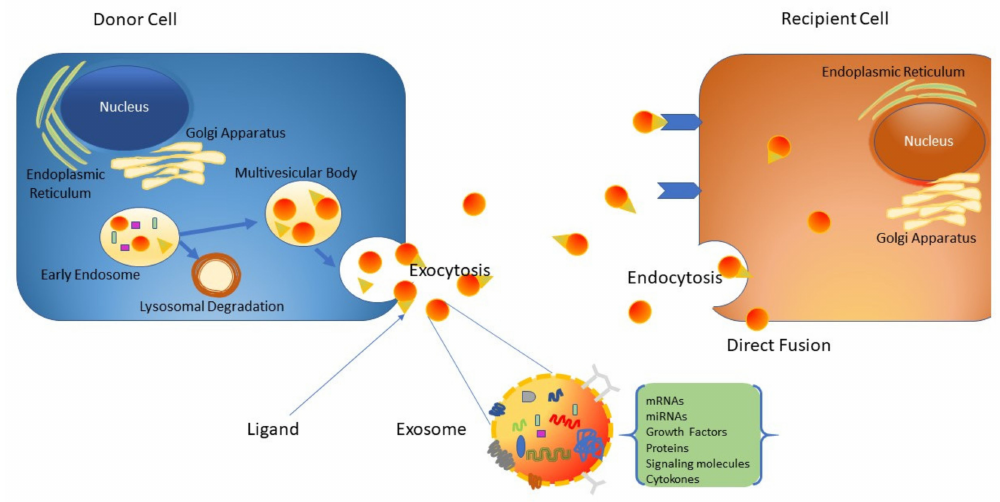
Figure 2. Schematic representation of exosome generation, secretion, and cargo transfer from the donor cells to the recipient